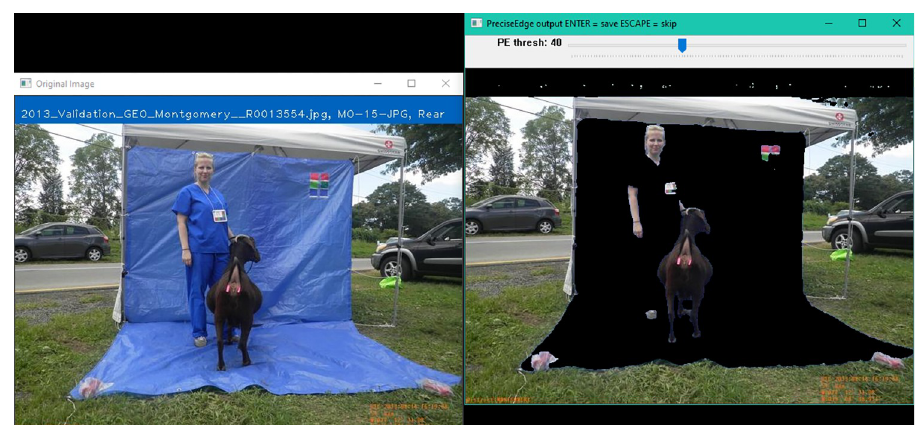
Fig 6. PreciseEdge Color Step GUI, reference image (left), interactive image